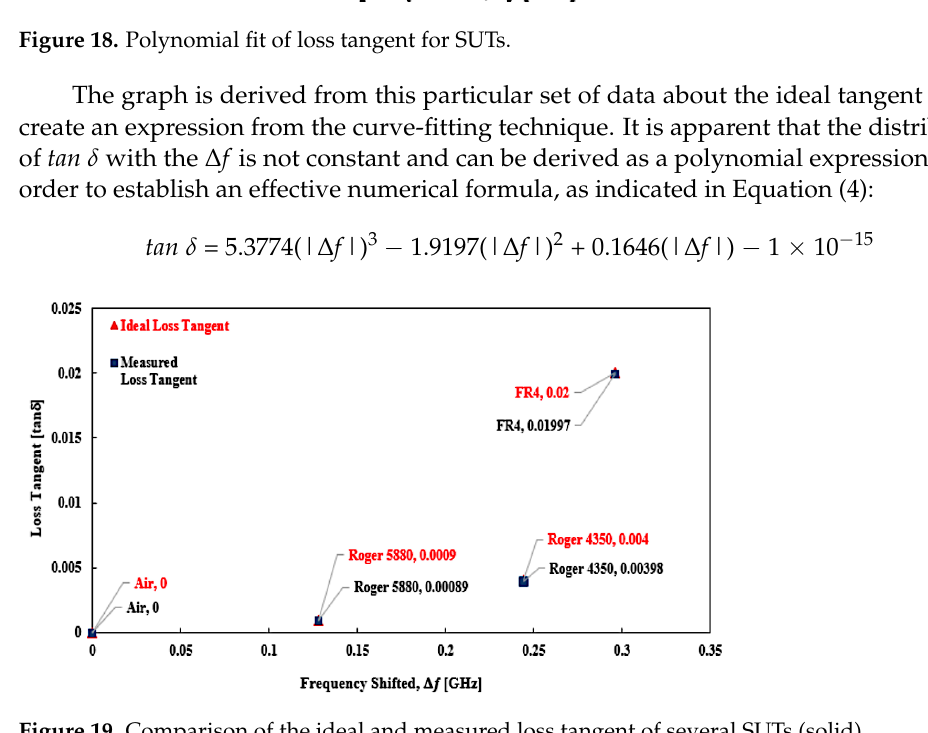
Figure 19. Comparison of the ideal and measured loss tangent of several SUTs (solid).